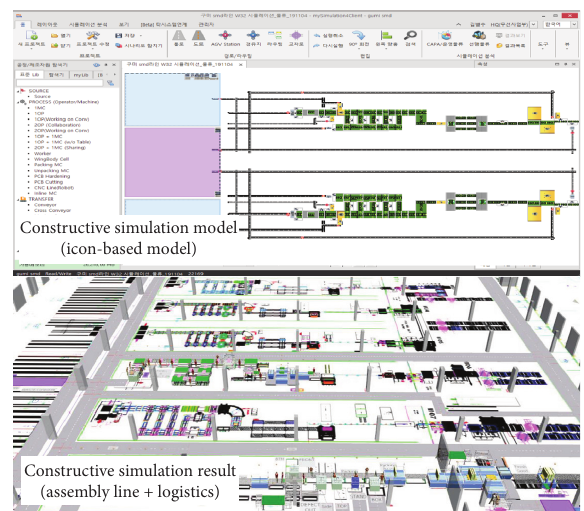
Figure 7: Application of constructive simulation in smart